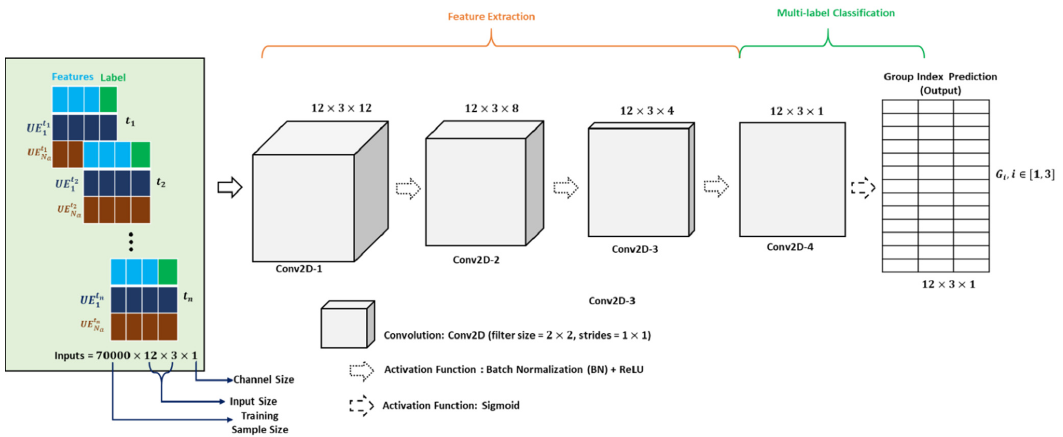
Figure 5. DLDC model for categorization of dataset into different groups.